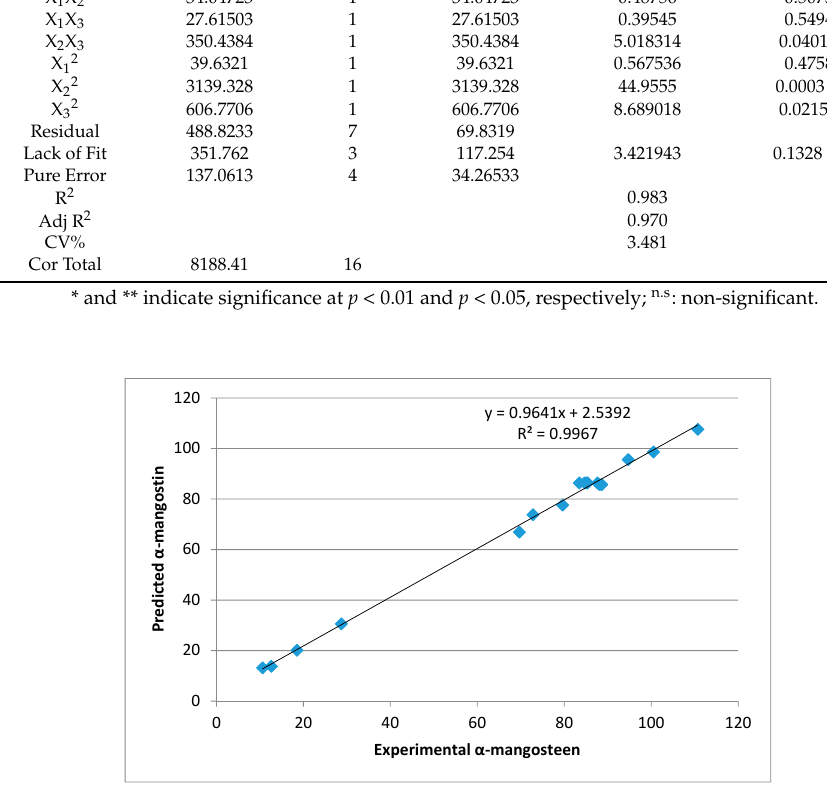
Figure 2. The regression of predicted and experimental values of α -mangostin.